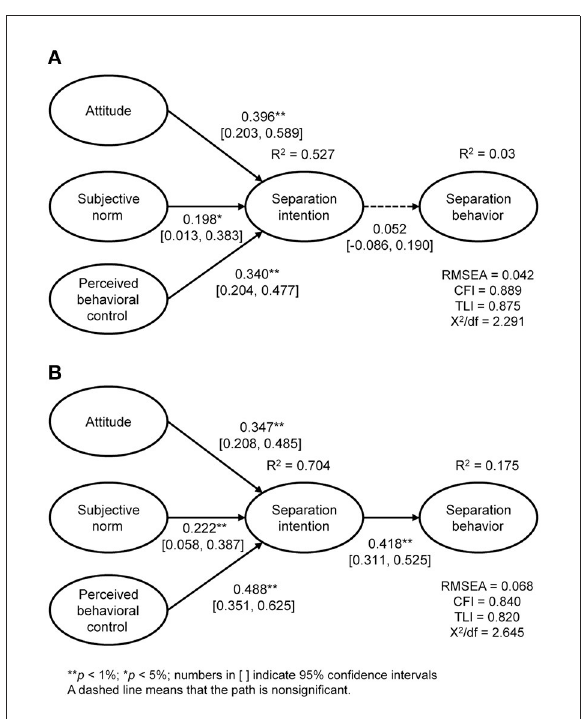
FIGURE1 SEM estimation results. (A) Survey 1 ( N = 290; Treatment group; May 12, 2022). (B) Survey 2 ( N = 188; Treatment group; July 21, 2022). ** p < 1%; * p < 5%; numbers in [ } indicate 95% confidence intervals. A dashed line means that the path